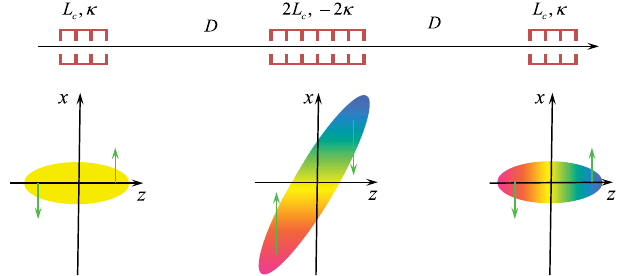
FIG. 1. The schematics of the TCBC beam line (above) consisting of three TCAVs for imposing longitudinal energy chirp in relativistic bunches. Subplots below show the x − z electron bunch distribution inside each TCAV. Green arrows in these plots show z -dependent deflection provided by each cavity, and the color shows the particle energy at the corresponding location (larger energy is shown as red and lower energy as